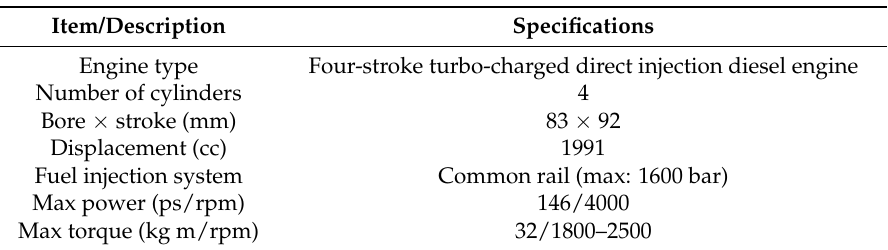
Table 3. Specifications of the test engine.